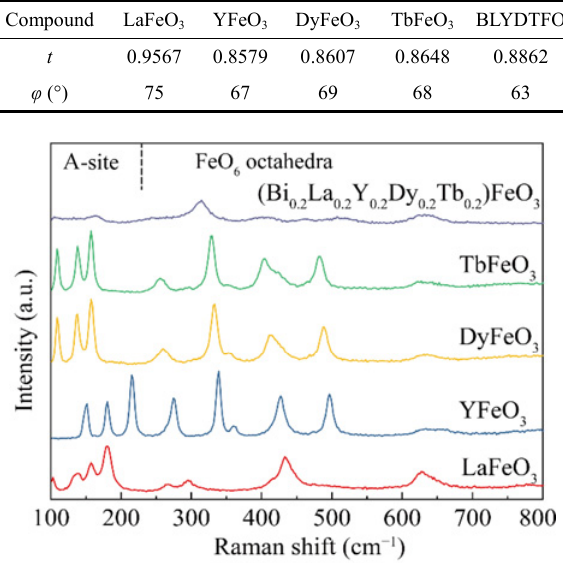
Fig. 6 Raman spectra of different ceramics measured at room temperature.